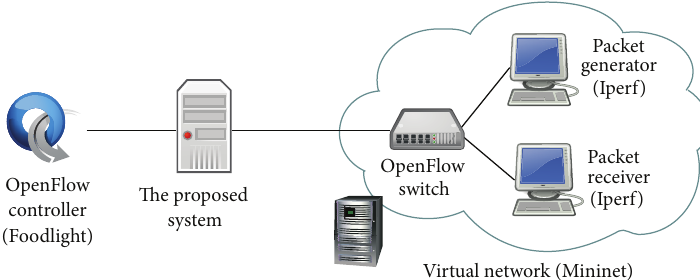
Figure 12: Network topology for evaluating packet capture performance.